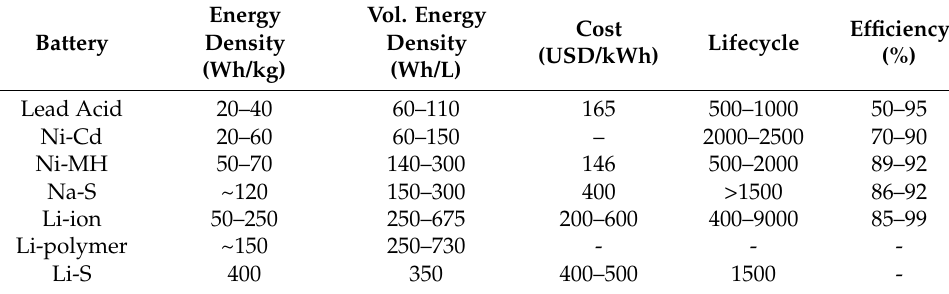
Table 5. Comparison of common battery types.